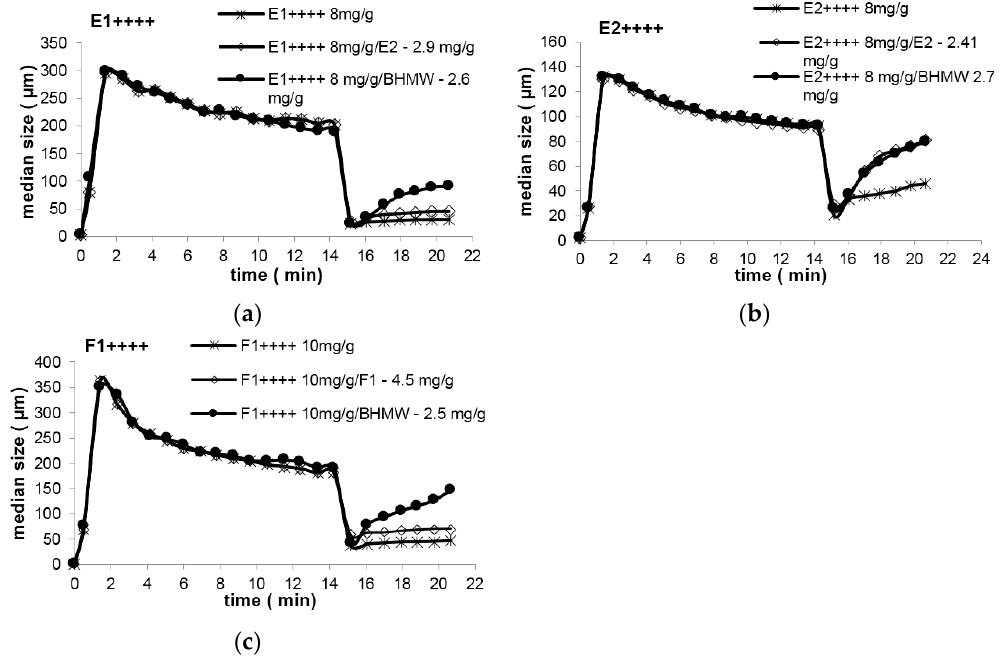
Figure 3. Re-flocculation with addition of linear polymer after flocs break-up: ( a ) E1++++/E2 and E1++++/BHMW; ( b ) E2++++/E2 and E2++++/BHMW; ( c ) F1++++/F1and F1++++/BHMW.